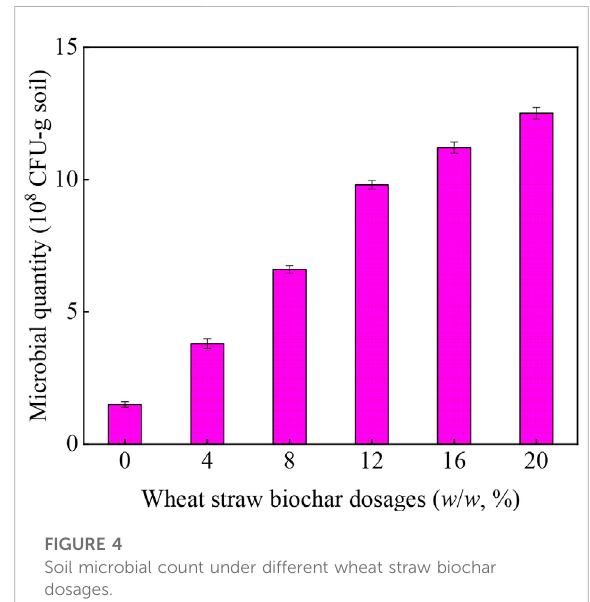
Soil microbial count under different wheat straw biochar